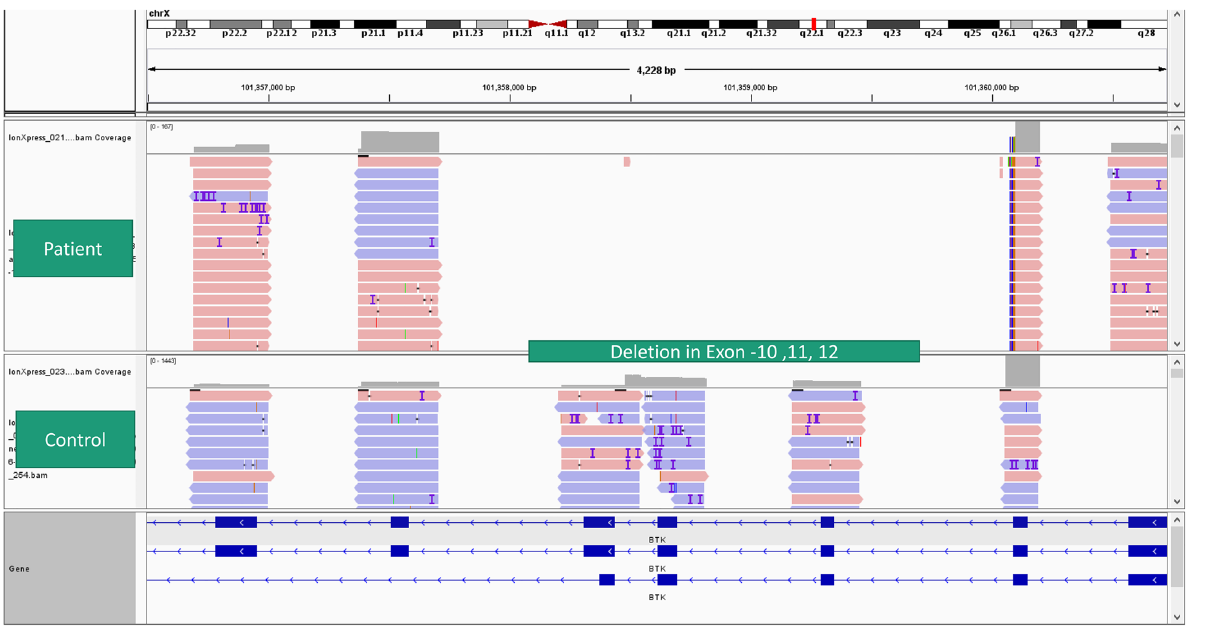
Figure 2. Large deletion of Exon- 10 to 12 in BTK gene on Integrative Genome